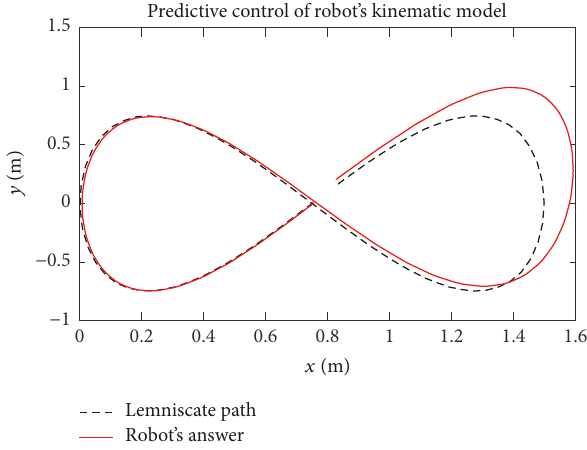
Figure 2: Lemniscate path following with the predictive control joined with the kinematic model.